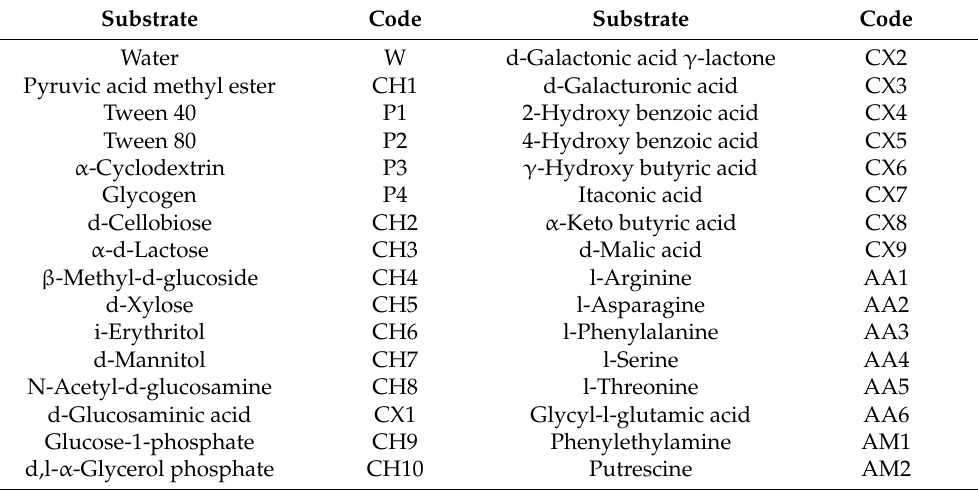
Table 3. Functional groups and guilds based on substrates in Biolog